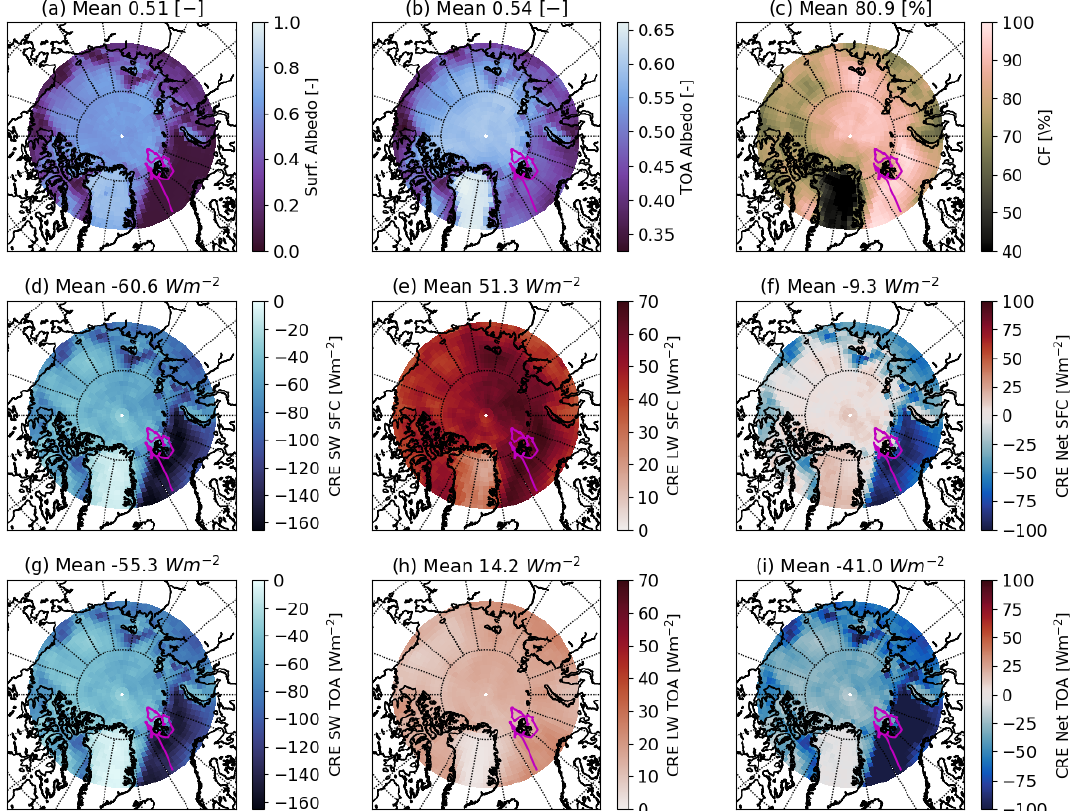
Figure 17. Maps of several time-averaged CERES SYN1deg data sets for the Arctic (70 to 90 ◦ N) and the time period of the PS106 expedition. Panel (a) shows the mean surface albedo ( α ), (b) the top of the atmosphere (TOA) albedo, and (c) the mean cloud fraction (CF). Panels (d) , (e) , and (f) show the CRE for the SW, LW, and net spectral regions, respectively, at the surface (SFC), while panels (g) , (h) , and (i) present the same at the TOA. An orthographic projection is used, and the PS106 cruise track is indicated in